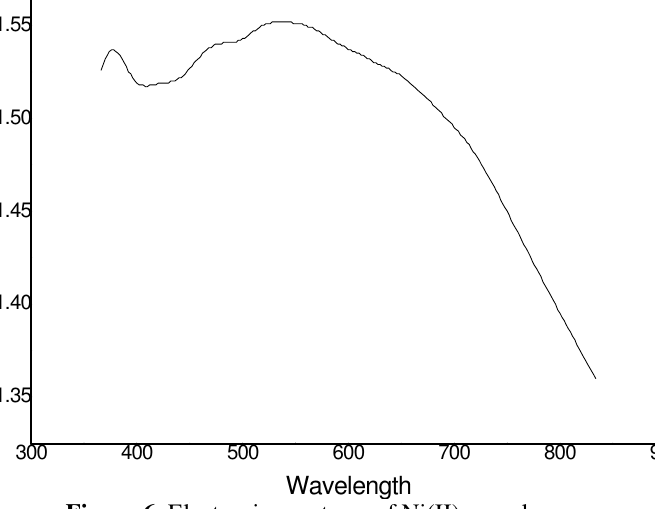
Figure 6 . Electronic spectrum of Ni(II) complex.